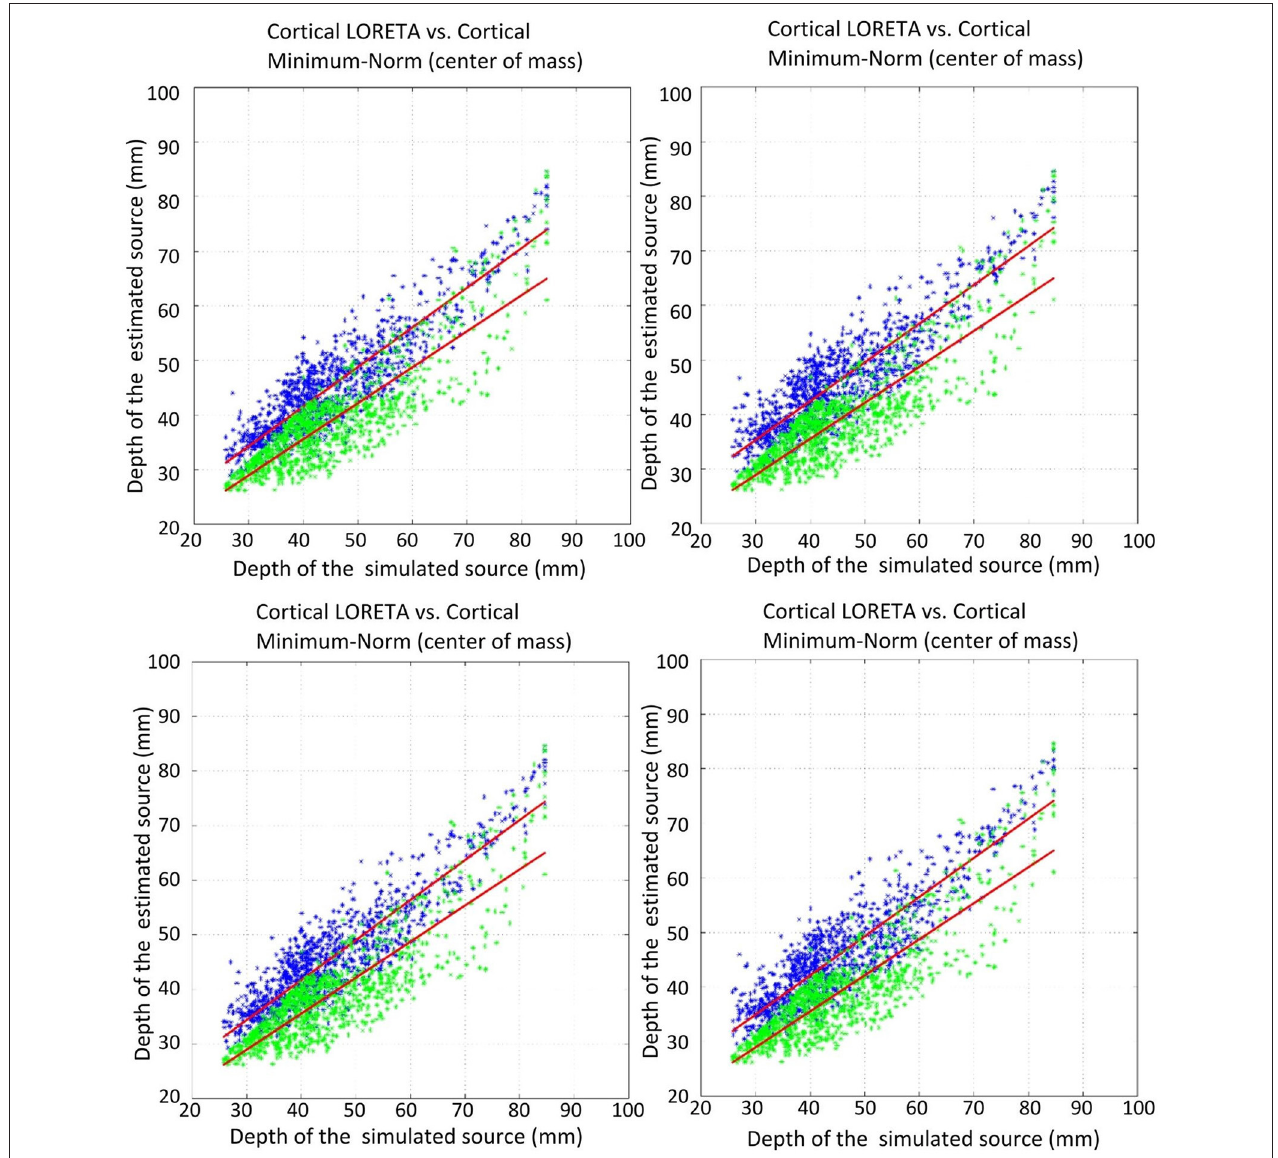
FIGURE 6 | Correlation of the estimated source depth (center of mass) with the simulated source depth. Green shows minimum-norm, blue depicts LORETA. The plots show: top left, unweighted graph Laplacian; top right, weighted graph Laplacian; bottom left, unweighted geometric Laplacian; bottom right, weighted geometric Laplacian.